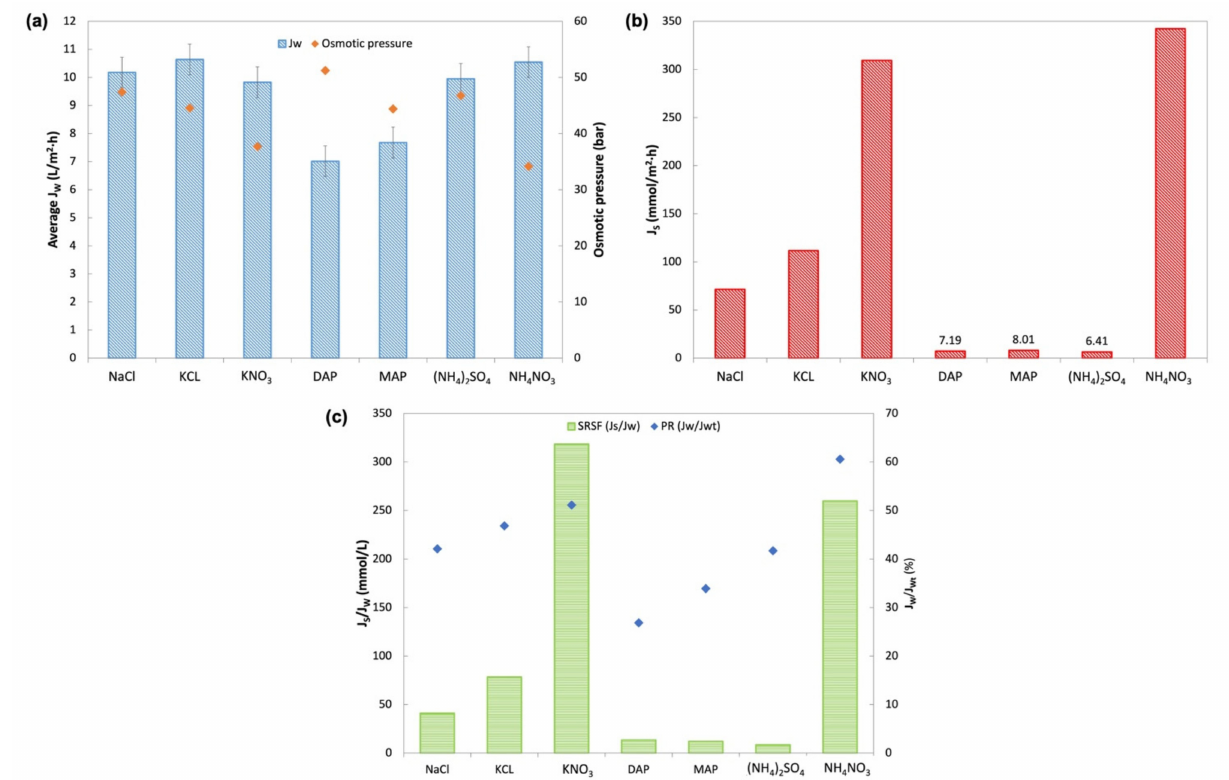
Figure 9. ( a ) Average water flux, J W , and osmotic pressure of the solution at 1 M concentration generated by OLI Stream Analyzer 9.6; ( b ) Reverse salt flux, J S ; ( c ) Specific Reverse Salt flux, SRSF, and performance ratio